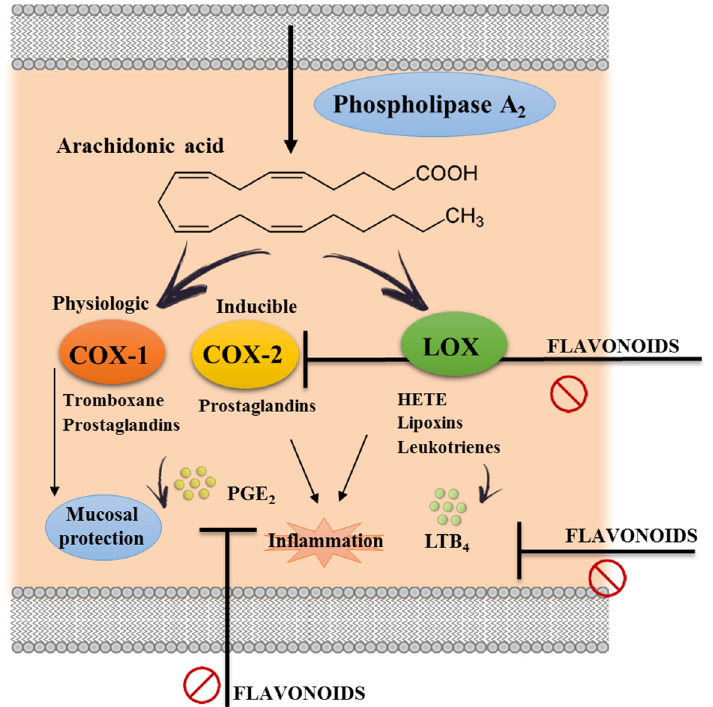
Figure 4. Eicosanoid synthesis pathways: Arachidonic acid is a polyunsaturated fatty acid that is released from the cellular membranes by cytoplasmatic phospholipase A 2 (PLA 2 ). Free arachidonic acid can be metabolized to eicosanoids through two major pathways: the cyclooxygenase (COX) and